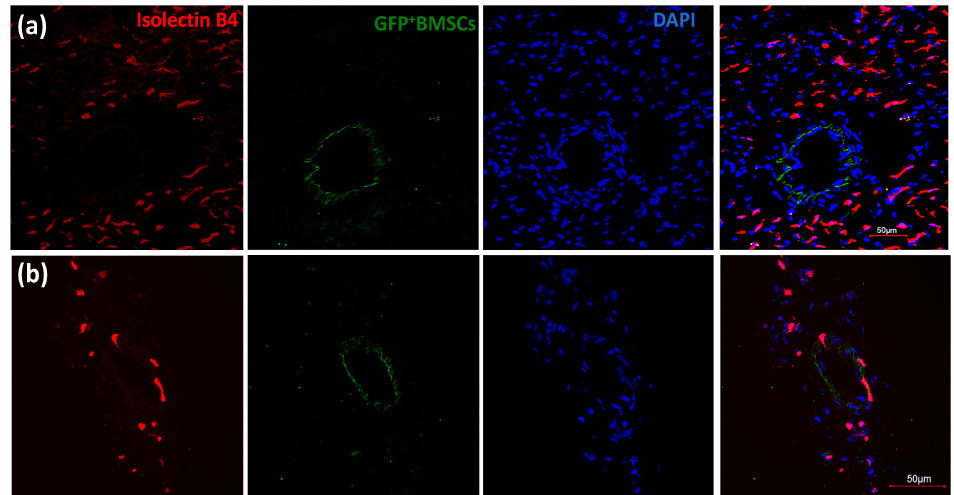
Figure 6. GFP + BMSCs aligned in the walls of large vessels. ( a , b ) are confocal images of chimeric rat hearts. The lumen size in ( a ) is bigger than a capillary, suggesting GFP + BMSCs contributed to the coronary collateral growth. There is colocalization of GFP + BMSCs and isolectin-B4 in ( b ), but the diameter of the vessel is smaller. Green shows GFP + BMSCs. Red shows the EC marker (isolectin-B4). Blue shows nuclei.